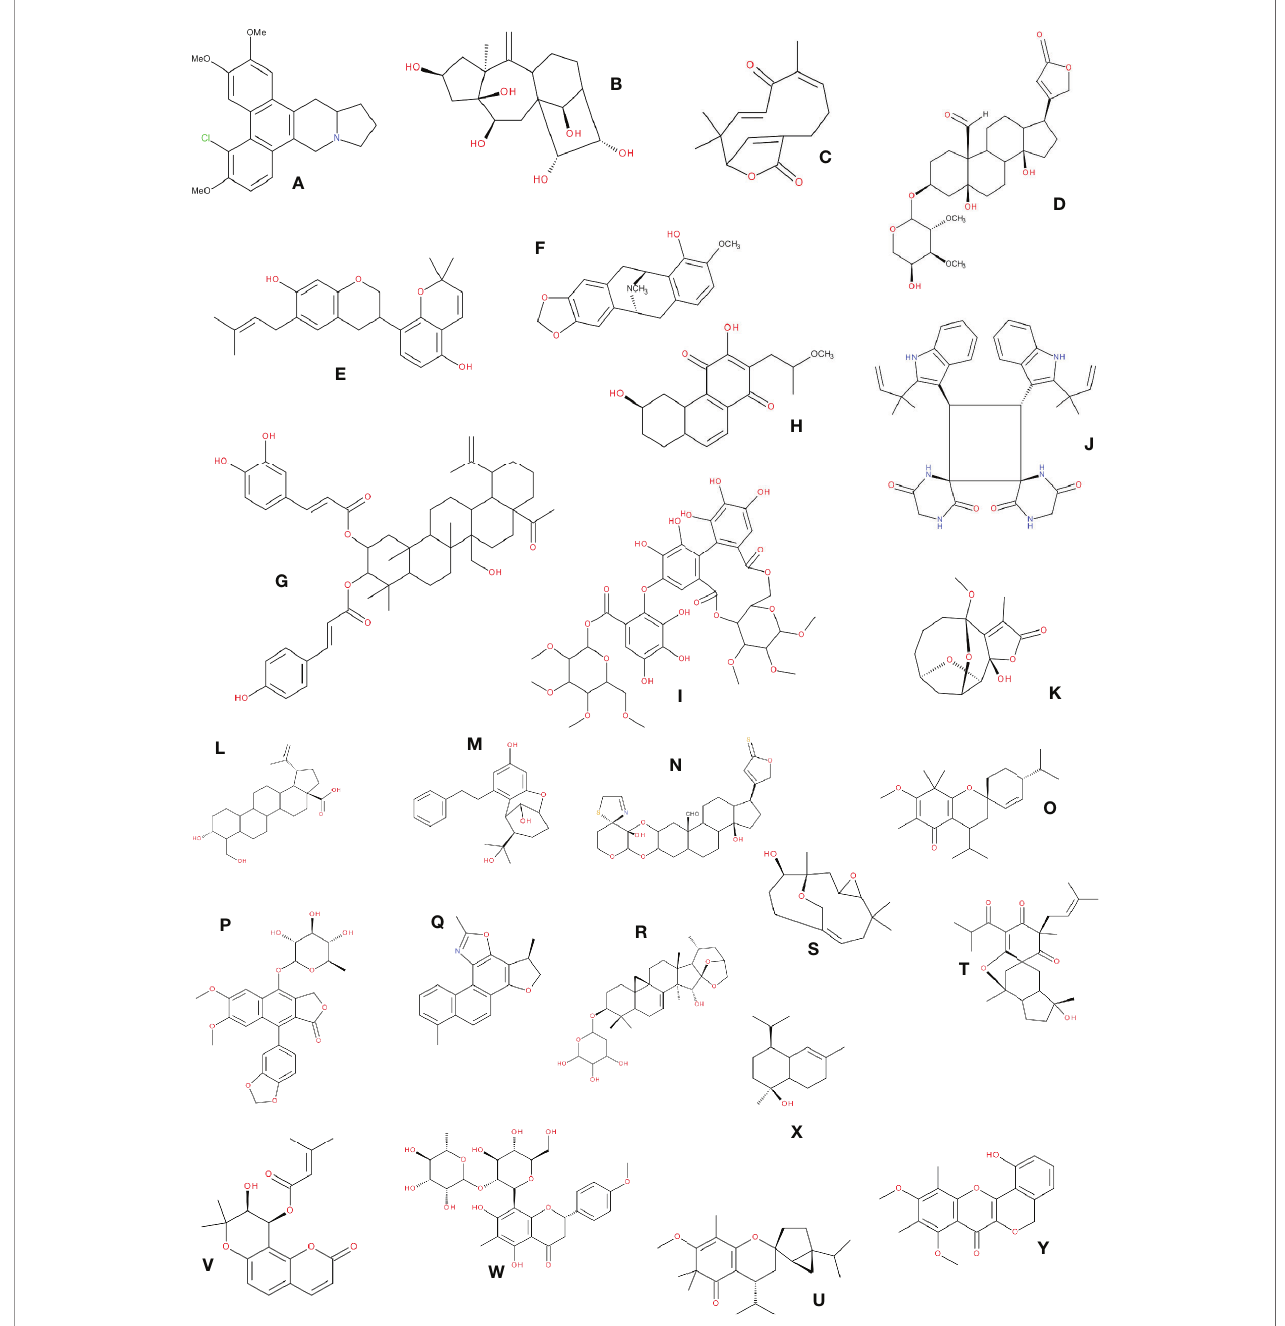
FIGURE 5 | Different types of molecules isolated from randomly chosen plants. Those molecules correspond to examples in Table 3 where the entries are in bold characters. (A) chlorinated phenanthroindolizidine (Al-Khdhairawi et al., 2017); (B) 3,4-seco-lupane-type triterpenoid (Cheng et al., 2018); (C) asteriscunolide C (Boumaraf et al., 2017); (D) (+)-strebloside (Ren et al., 2017); (E) Glycybridin D (Li et al., 2017); (F) (-)-neocaryachine (Suzuki et al., 2017); (G) plectranthroyleanone A (Nzogong et al., 2018); (H) uncarilin A (Geng et al., 2017); (I) 27-hydroxyalphitolic acid derivative (Novakovic et al., 2017); (J) Isorugosin (Shimozu et al., 2017); (K) carpescernolide A (Yan et al., 2018); (L) 3 a ,24-dihydroxylup-20(29)-en-28-oic acid (Valencia-Chan et al., 2017); (M) rasumatranin A (Wang et al., 2017); (N) uscharin (Yoneyama et al., 2017); (O) baeckfrutone A (Qin et al., 2018); (P) patenti fl orin A (Zhang et al., 2017b); (Q) salvianan A (Zhang et al., 2017); (R) cimiricaside B (Thao et al., 2017); (S) aquilanol A (Ma et al., 2017); (T) hyperhenone G (Duan et al., 2018); (U) frustescone O(Hou et al., 2017); (V) dihydropyrano-coumarin derivative (Hong and Kim, 2017); (W) matteuorienate A (Huh et al., 2017); (X) t-muurolol (Pérez-Colmenares et al., 2018); (Y) bougainvinones I (Do et al., 2018). Note: for most of those compounds, the stereospeci fi city was